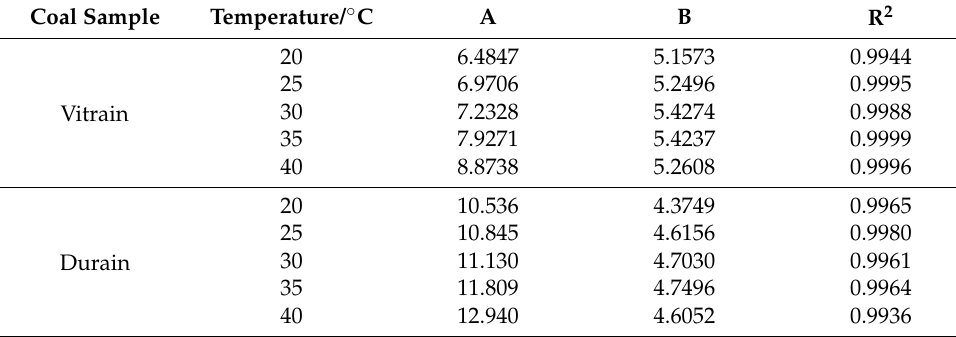
Table 9. ln f -n fitting results of the methane desorption process at different temperatures.